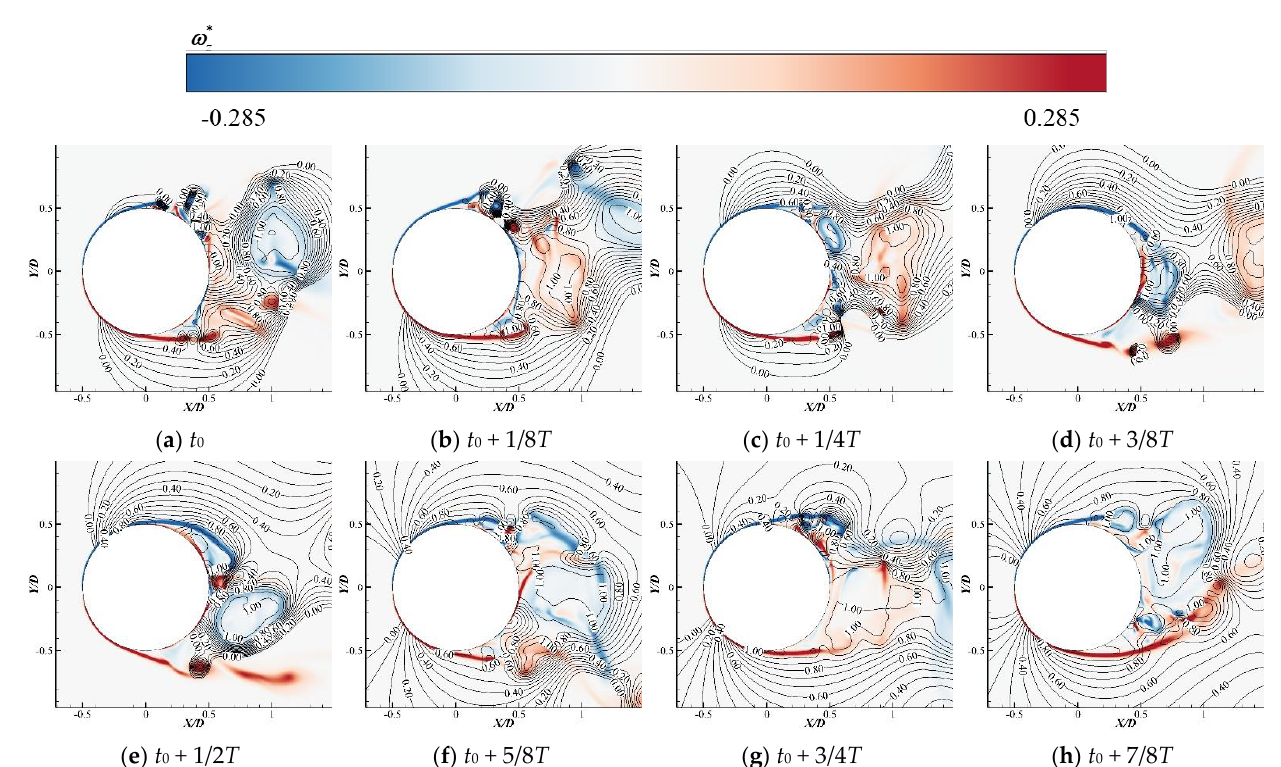
Figure 6. Evolutions of the cavitating vortices and the pressure in a quasiperiod at σ = 2.52.